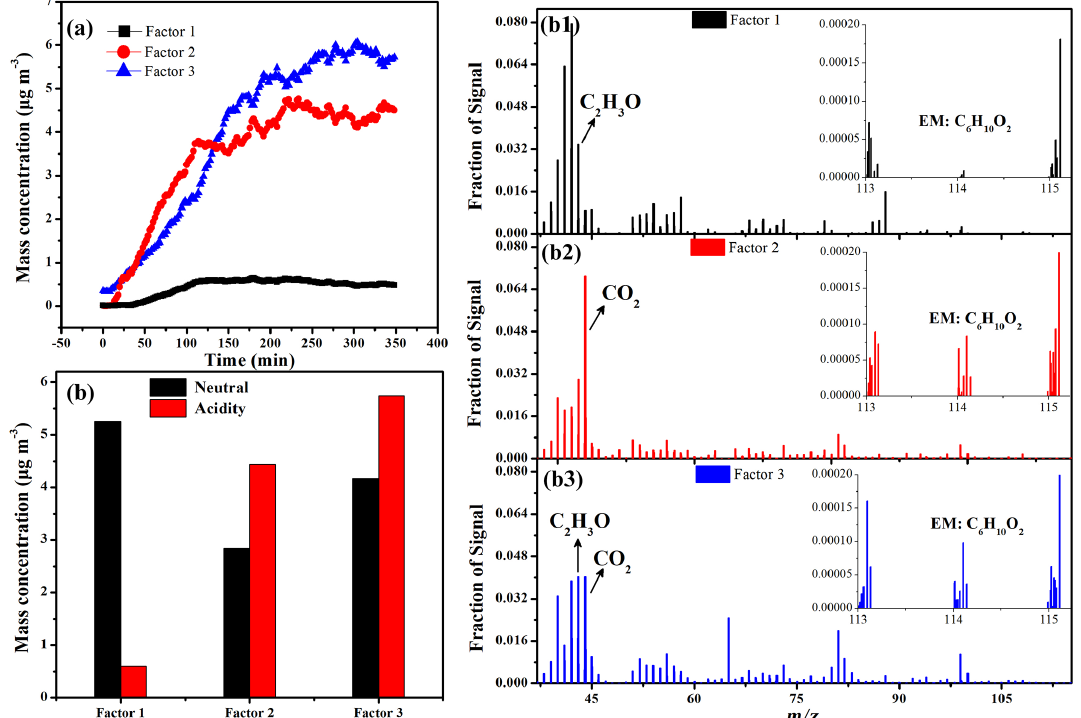
Figure 4. Three-factor solutions for PMF analyses of SOA under different seed particles: (a) time series of factor concentrations under acidic AAS; (b) mass spectra of three factors; (c) comparison of maximum concentration of two factors under neutral AS (black) and acidic AAS (red).